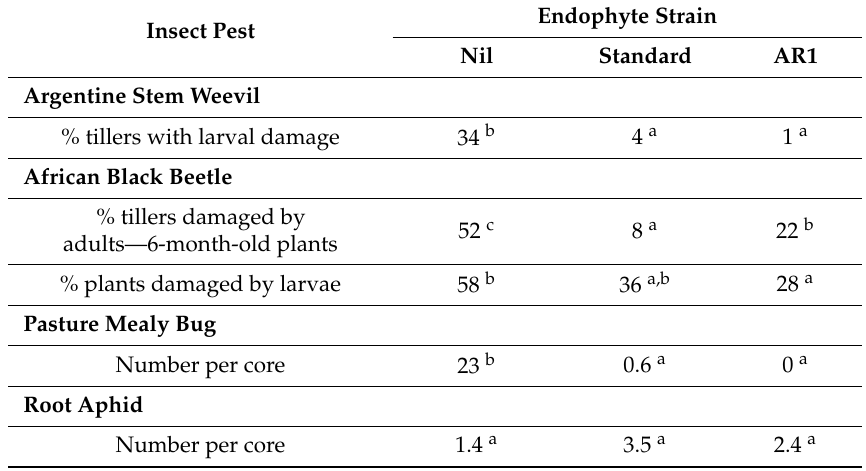
Table 6. E ff ects of AR1 endophyte strain in perennial ryegrass on pasture pests. (Taken from [282]). Endophyte Strain Insect Pest Nil Standard AR1 Argentine Stem